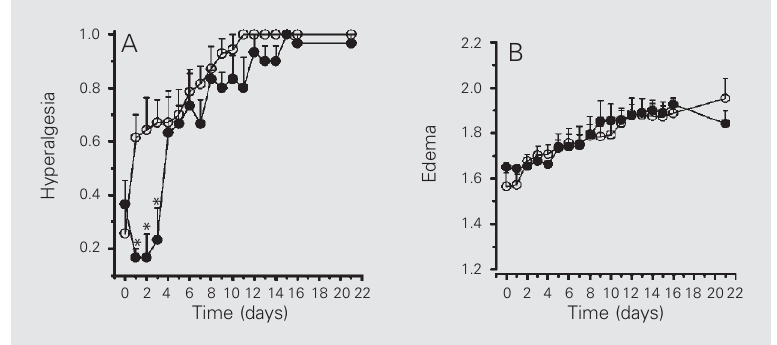
Figure 4. Effect of celecoxib (filled circles) on the hyperalgesia and edema responses of adrenalectomized old arthritic rats (control, open circles). Celecoxib (3 mg/kg) was adminis- tered daily by gavage starting immediately after surgery, 5 days before arthritis was induced, and continued until the last day of the experiment. N = 3/group. See legend to Figure 1 for a description of the induction of arthritis. *P<0.05 compared to untreated adrenalectomized old arthritic rats (two-way